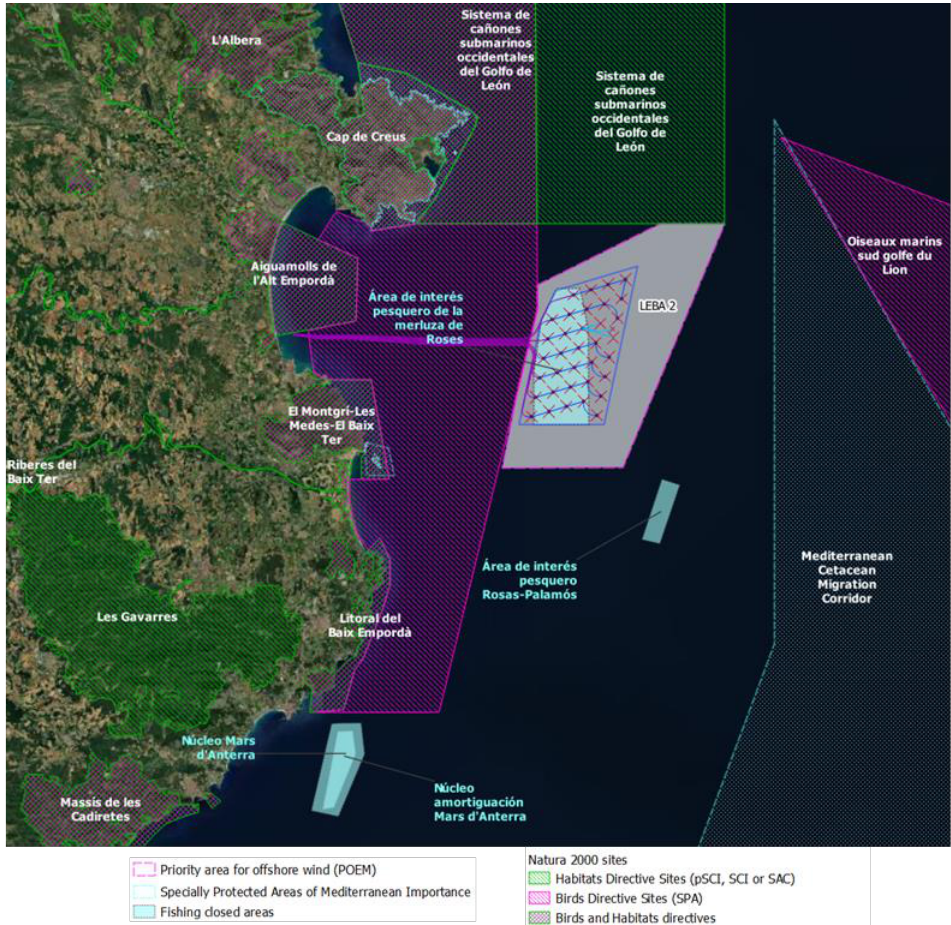
Figure 1. Location of the Tramuntana Floating Offshore Wind Farm Project in relation to environmental protected sites and other uses of maritime space.